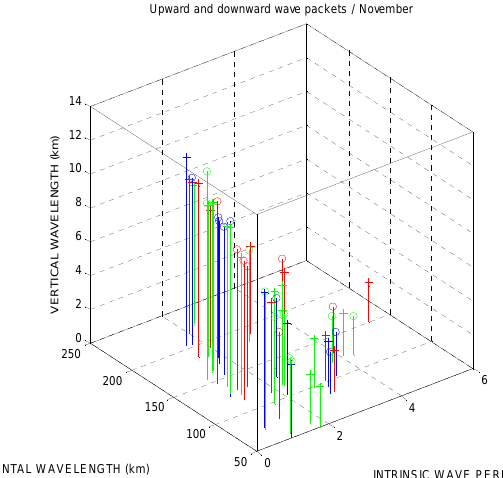
Fig. 3. Three-dimensional plots of relation among horizontal wave λ , vertical Fig.3 Three dimensional plots of relation among horizontal wave length length λ h , vertical wavelength λ z and intrinsic wave period τ in of h upward and downward moving virtual gravity wave packets in the Fig. 4. Same as Fig. 3 except for the month of month of November. “o” stands for upward-, while “ + ” for down- λ and intrinsic wave period τ of upward and downward moving wavelength z in ward propagating virtual gravity wave packets; blue denotes 1986; Fig.4 Same as Fig.3 except for the month of July. red denotes 1988; and green denotes 1989. The vertical color lines virtual gravity wave packets in the month of November. ‘o’ stands for upward-, 815 connecting the points of (cid:0) τ in, λ h ,λ z (cid:1) with their projections on the while ‘+’ for downward propagating virtual gravity wave packets; Blue color (τ in ,λ h ) plane were drawn for easy viewing. denotes the year of 1986; red color denotes the year of 1988; and green color denotes the year of 1989. The vertical color lines connecting the points of ( ) τ λ plane were drawn for easy , τ λ λ with their projections on the ( , ) in h , in h z viewing. 820